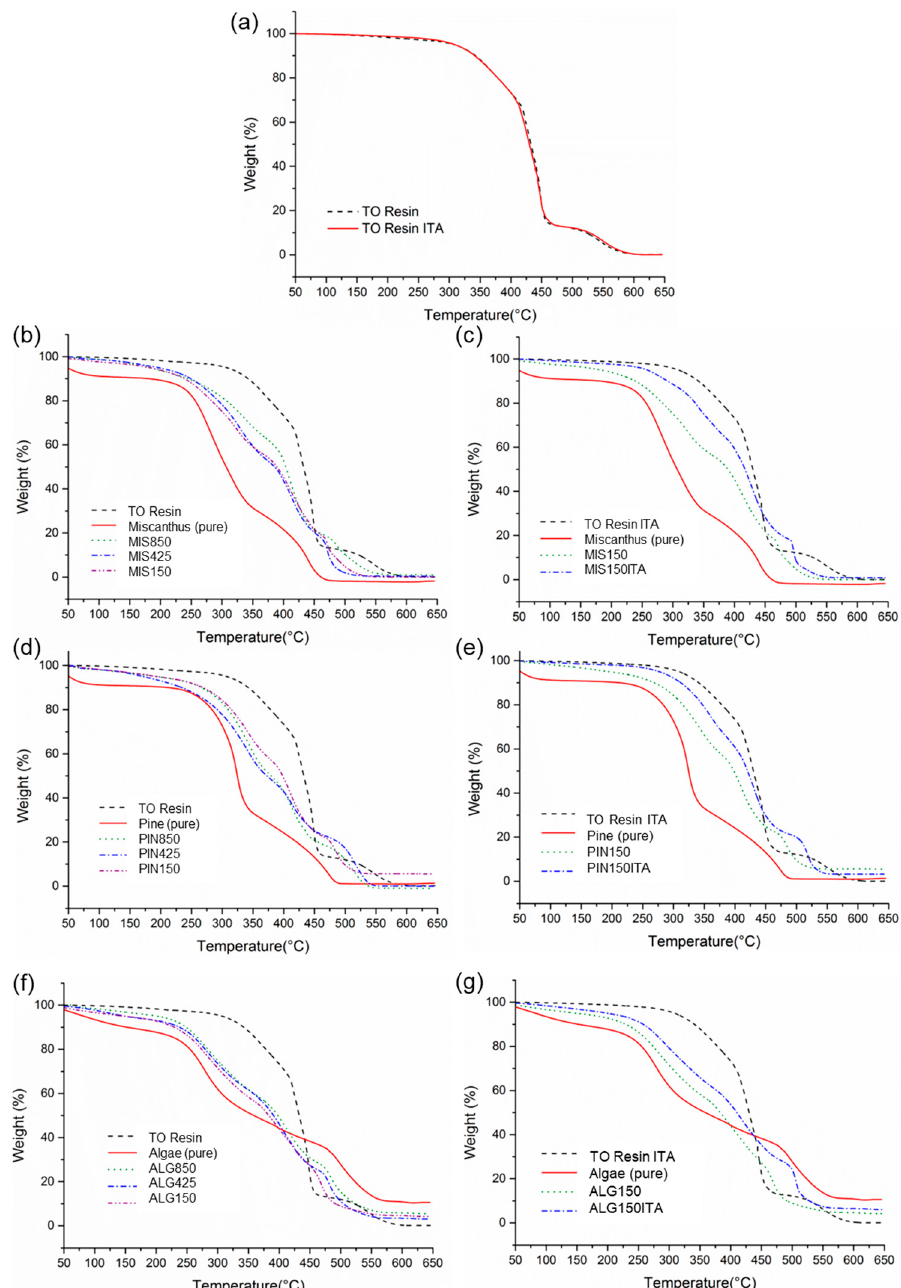
Figure 2. TGA curves of resins without reinforcement ( a ), silvergrass composites with different particle sizes ( b ), silvergrass composites with and without ITA ( c ), southern pine composites with different particle sizes ( d ), southern pine composites with and without ITA ( e ), algae composites with different particle sizes ( f ), and algae composites with and without ITA ( g ).